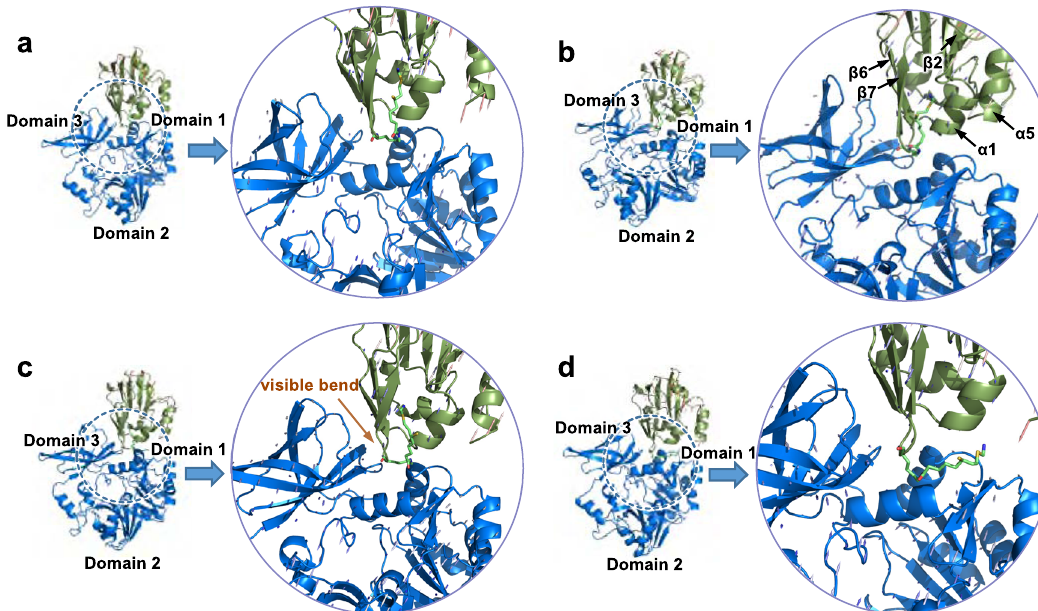
Fig. 5 Conformational changes of ecH int -ecT interaction in the induction process of protein H by protein T. a – d correspond to the steps A to B, C to D, E to F, and G to H of Fig. 4,